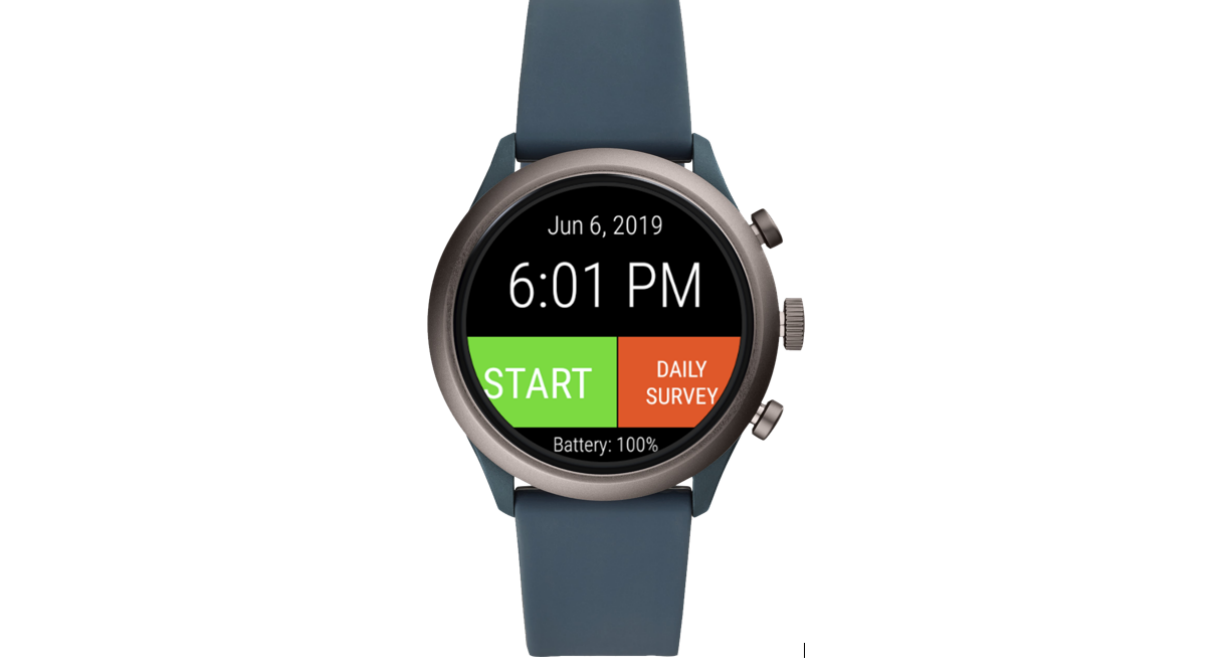
Figure 5. Behavioral and Environmental Sensing and Intervention for Cancer (BESI-C) smart watch with custom